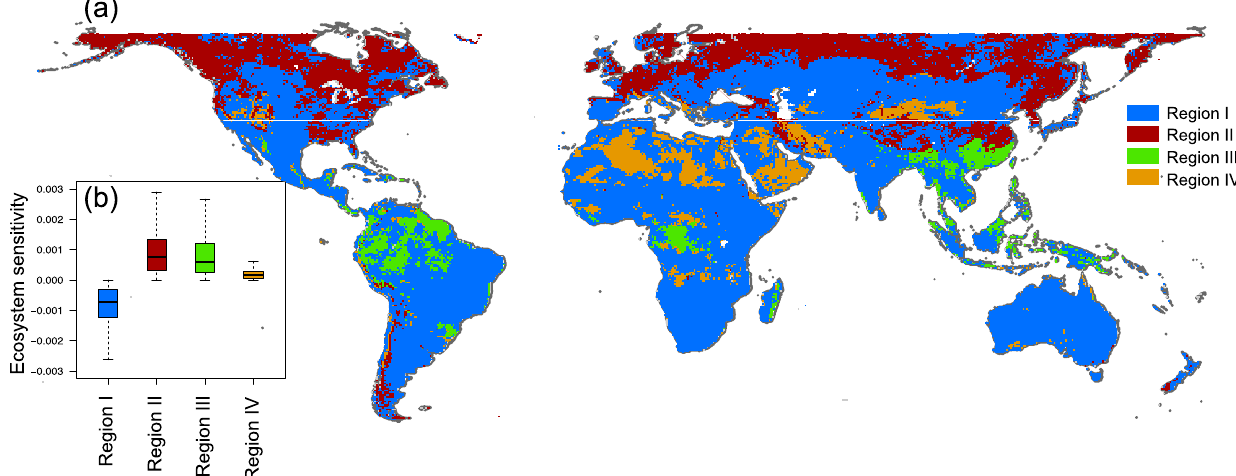
Fig. 2 Delineation of regions of global terrestrial surface. a Four regions are delineated in this study. Region I denotes areas of negative sensitivity; regions with positive sensitivity include Region II where energy limitation is likely, Region III denoting humid tropical regions, and Region IV denoting desert and xeric regions. Detailed de fi nitions of each region are provided in Fig. 1. b Distribution of ecosystem sensitivity values by region. Box plots: box limits show the fi rst quartile (Q1) and third quartile (Q3); central line inside the box represents the median ecosystem sensitivity of a given region; and the segments at ends indicate (Q1 – 1.5 interquartile range) and (Q3 + 1.5 interquartile